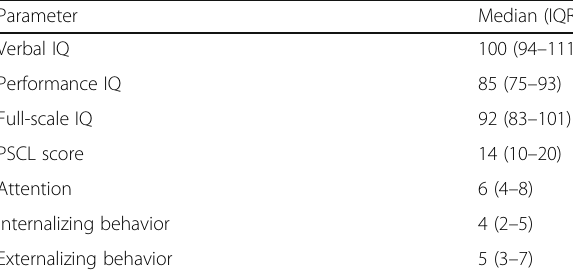
Table 2 Median and range of different IQ scales and